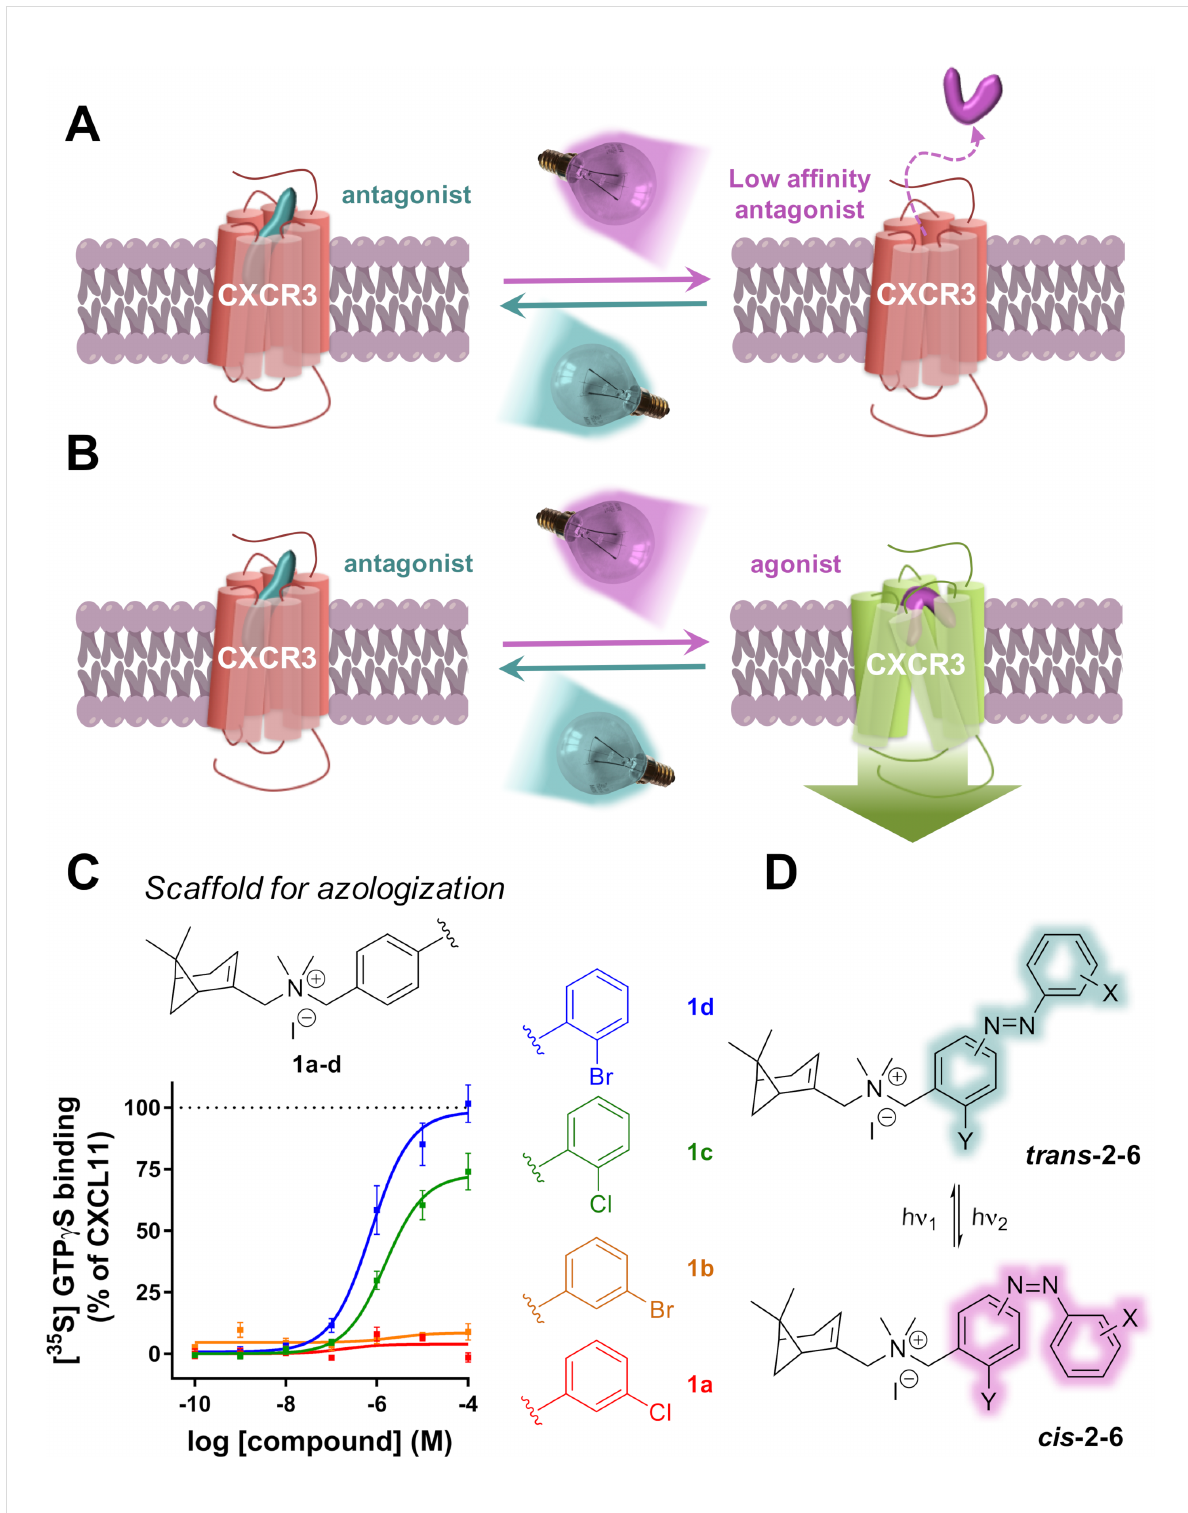
Figure 1: Design of the CXCR3 efficacy photowitchable ligands. A,B) Schematic representation of a GPCR photochromic ligand that photoisomerizes and thereby photoswitches (A) binding affinity and/or (B) functional efficacy. Red represents the inactive GPCR, while green represents the active GPCR. C) General structure and exemplary functional dose-response curves of the parent biaryl family of CXCR3 ligands disclosed in Wijtmans et al. [24], in which ortho substitution on the outer aromatic ring gives partial or full agonists, while meta substitution provides antagonists. D) Azologization of the biaryl moiety provides a family of photowitchable CXCR3 small-molecule